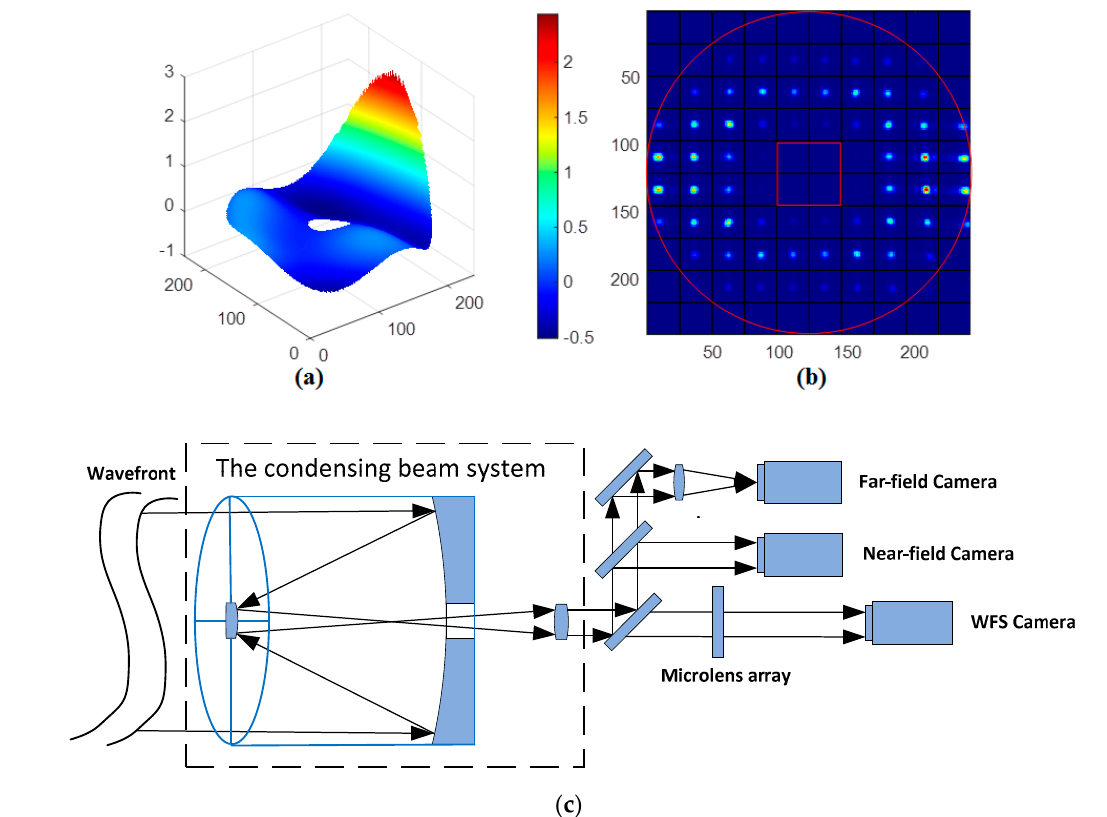
Figure 6. ( a ) Random wavefront phase distribution, ( b ) the sub-aperture light spot image of WFS, ( c ) WFS with the Cassegrain structure.